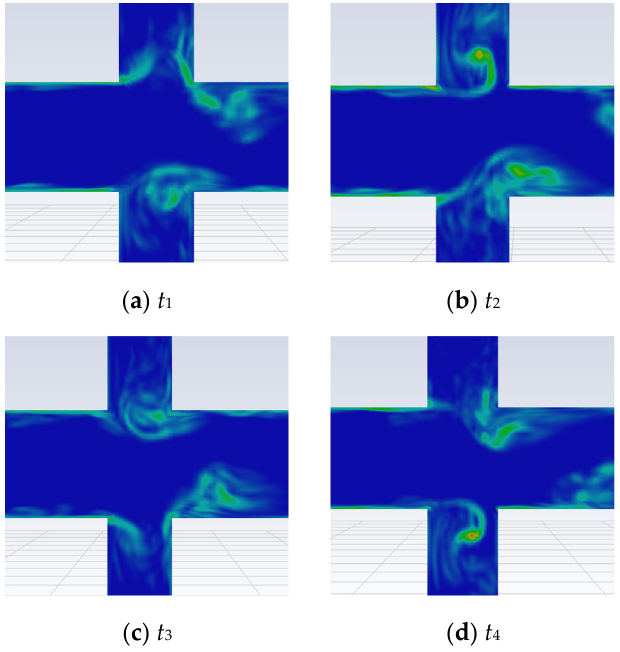
Figure 2. Vortex shedding process in an acoustic period ( m = 1, h = 1).